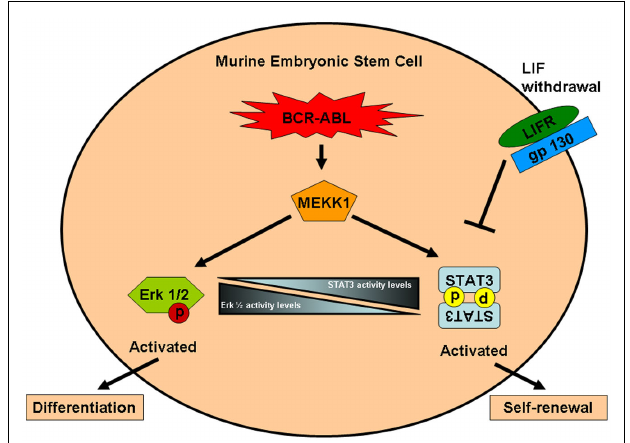
FIGURE 2 | Regulation of self-renewal and differentiation in bcr–abl transformed murine embryonic stem cell. In bcr–abl transformed murine embryonic stem cell, STAT3 is activated in the LIF-independent MEKK1-dependent manner. Activation of MEKK1 by bcr–abl also leads to activation of Erk 1/2. It has been proposed that increased STAT3 activity within the stem cell promotes self-renewal and inhibition of differentiation, however decreased STAT3 activity leads to increased Erk 1/2 activity which in turn promotes rapid differentiation.This model has to be tested in bcr–abl transformed human stem cells. STAT3, signal transducers and activators of transcription 3; LIFR, leukemia inhibitory factor; Erk 1/2, extracellular signal-regulated kinases 1/2; MEKK1, mitogen-activated protein kinase kinase